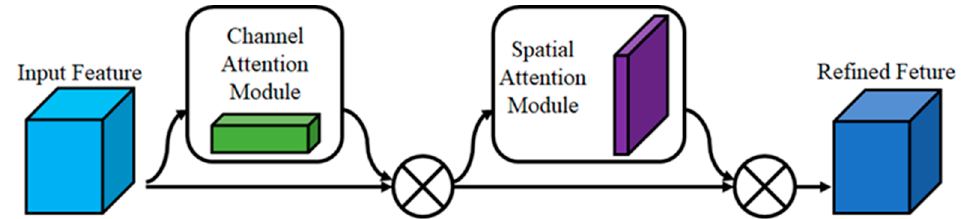
Figure 3. CBAM Architecture. Figure 3. CBAM